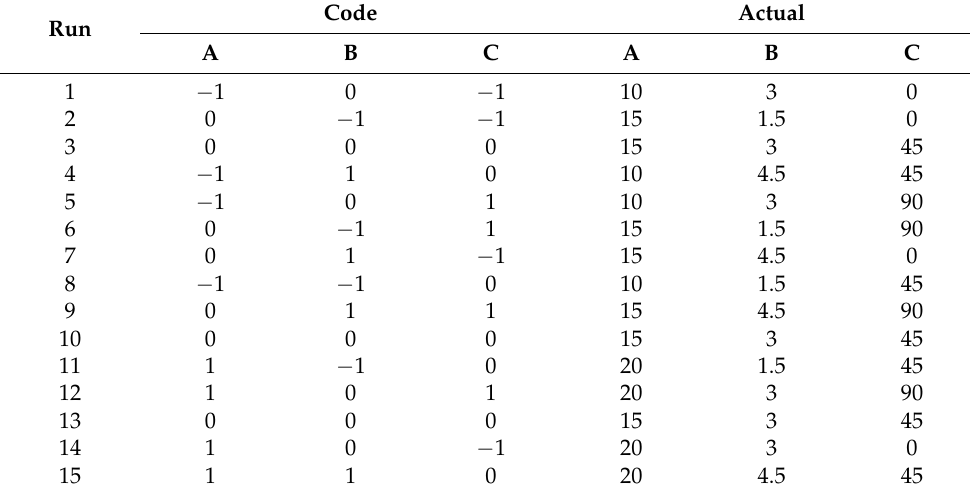
Table 3. Experimental